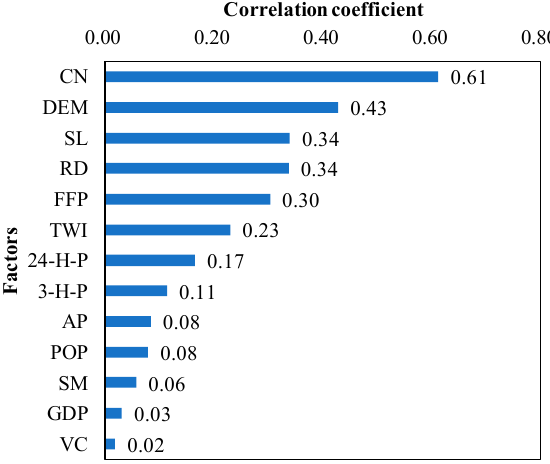
Figure 7. The correlation coefficient between the flash flood risk and 13 indicators.